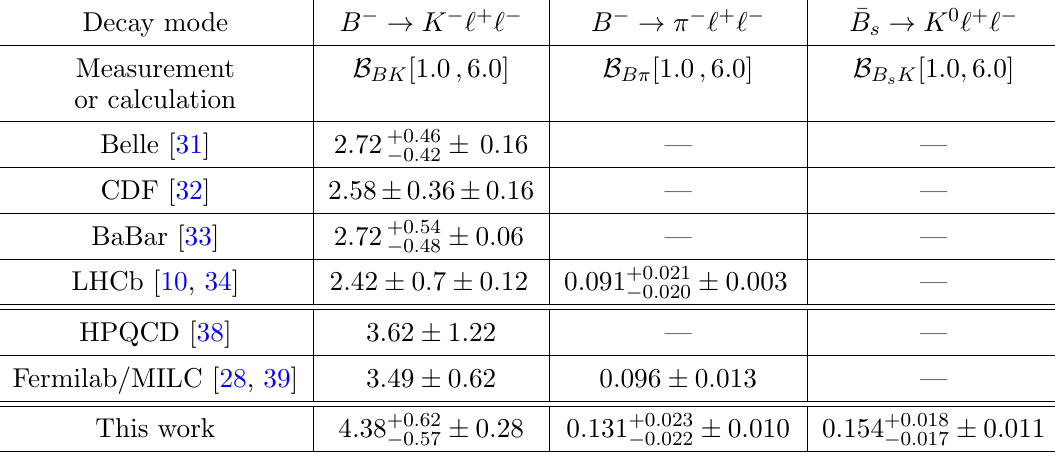
Table 5 . Binned branching fractions in the units of 10 (cid:0) 8 GeV (cid:0) 2 de(cid:12)ned in eq. (2.15) for the bin [ q 2 ; q 2 ] = [1 : 0 GeV 2 (cid:0) 6 : 0 GeV 2 ] . The (cid:12)rst (second) error in our predictions is due to the uncertainty 1 2 of the input (only of the CKM